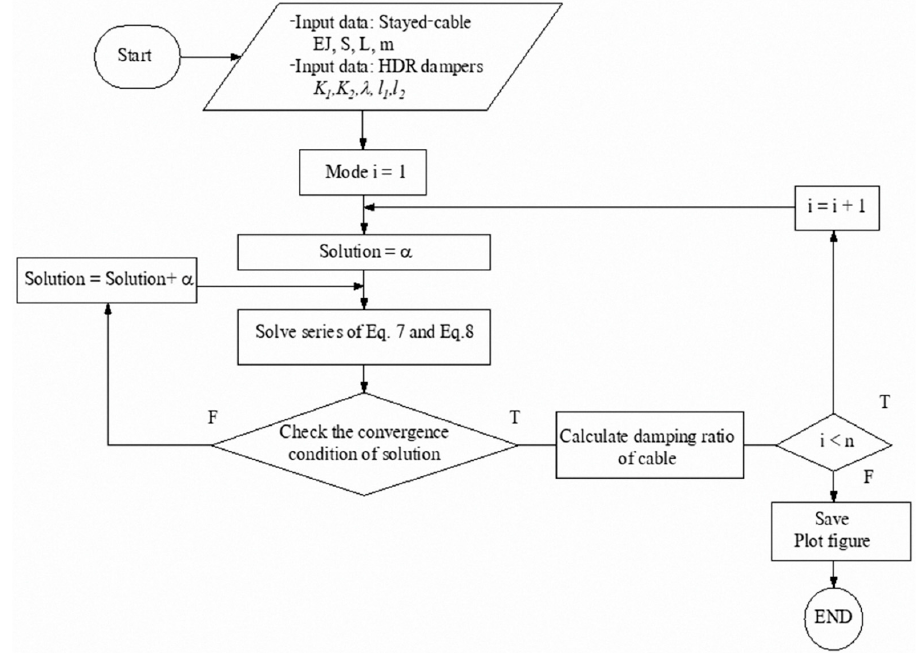
Figure 2. Model algorithm.